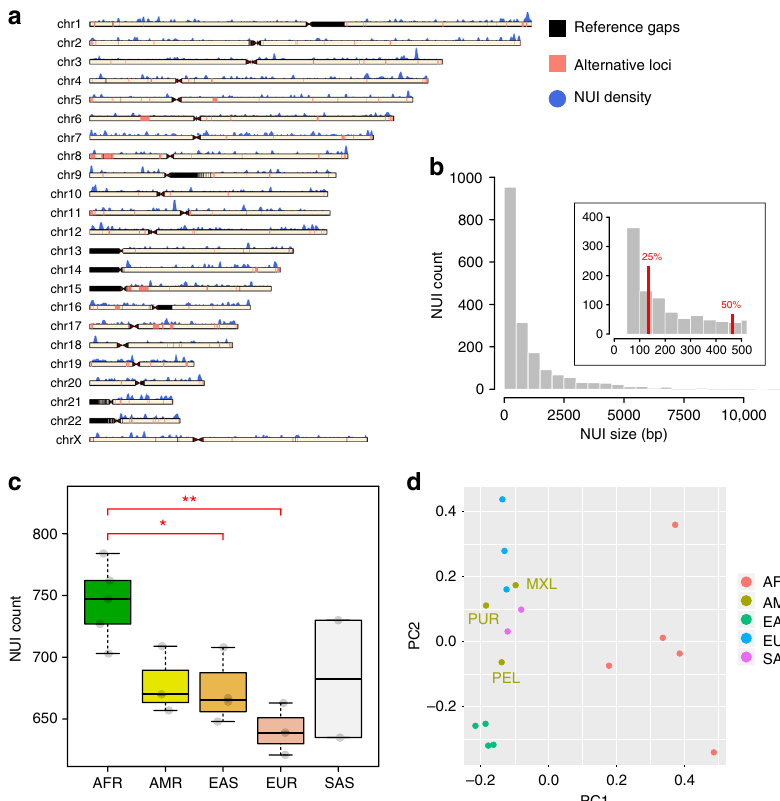
Fig. 1 Overview of the non-reference unique insertions and their distributions across populations. a Ideogram depicting NUI occurrences across all chromosomes. The blue histogram above each chromosome describes the number of NUI using a sliding window of 1 Mb with a 10 kb step size. Alternative loci incorporated in hg38.p11 are shown in pink, and for display purpose, the sizes of these loci are extended by 100 kb on both sides. b NUI size distribution using a bin size of 500 bp in the main plot and 50 bp in the zoomed area. The 25th and 50th percentiles are labeled in red. NUIs longer than 10 kb in length were removed before plotting. c The number of NUIs across all fi ve super-populations. Each gray dot shows the actual NUI number per individual. ANOVA F (4,12) = 5.643, p = 0.0086 followed by Tukey [AFR-EAS] p = 0.0389033; [AFR-EUR] p = 0.0067794. The box plot illustrates the median, the upper and lower quartiles for each population. Since no points exceed the 1.5 X interquartile range, the whiskers correspond to the minimum and maximum values in each group. (* p ≤ 0.05; ** p ≤ 0.01). d The fi rst two principal components based on the NUI occurrence matrix. The sub-populations of the American samples were labeled on the plot. AFR Africans, AMR Americans, EAS East Asians, EUR Europeans, SAS South Asians. American sub-populations: